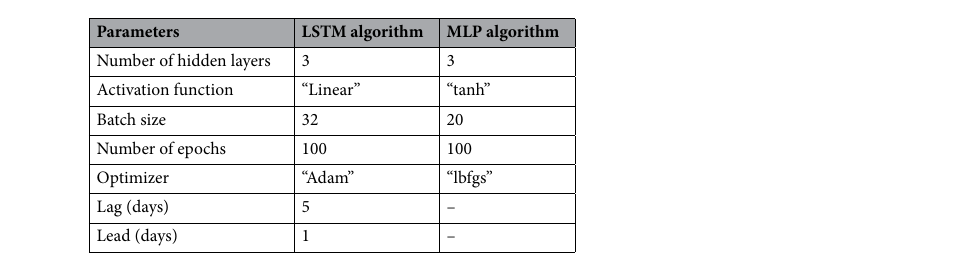
Figure 5. Schematic diagram of the proposed framework ( a ) univariate and ( b ) multivariate models.